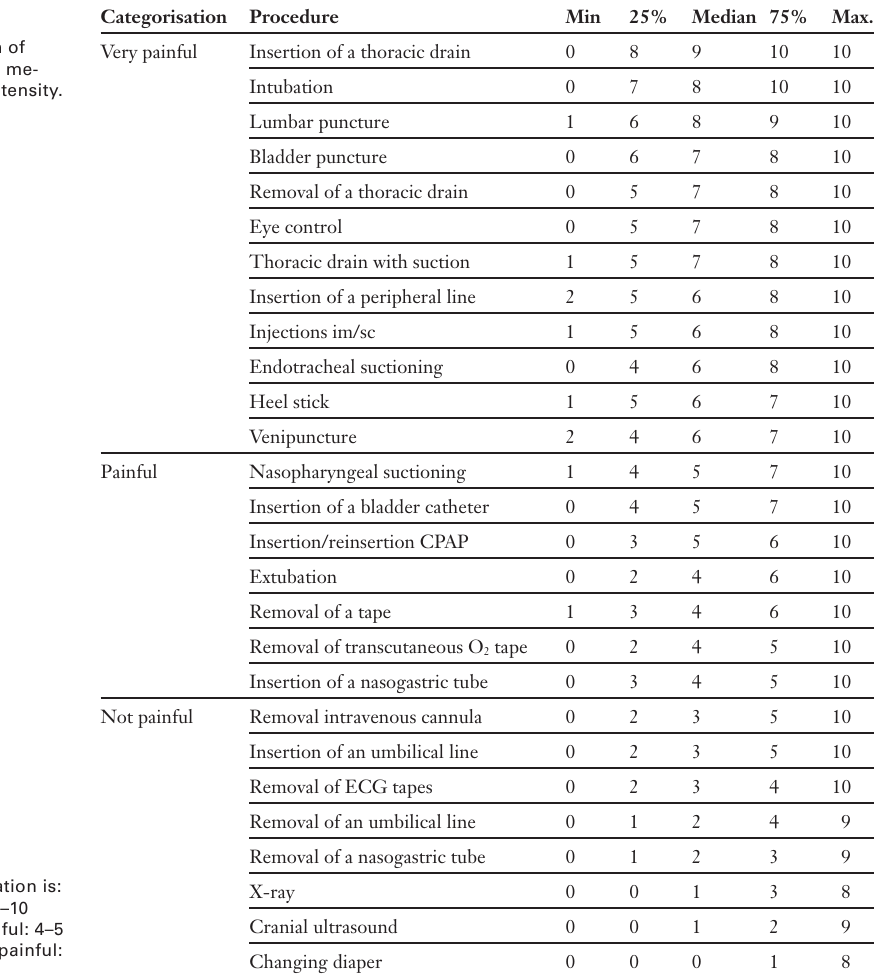
Table 2 Categorisation of procedures by me- dian of pain